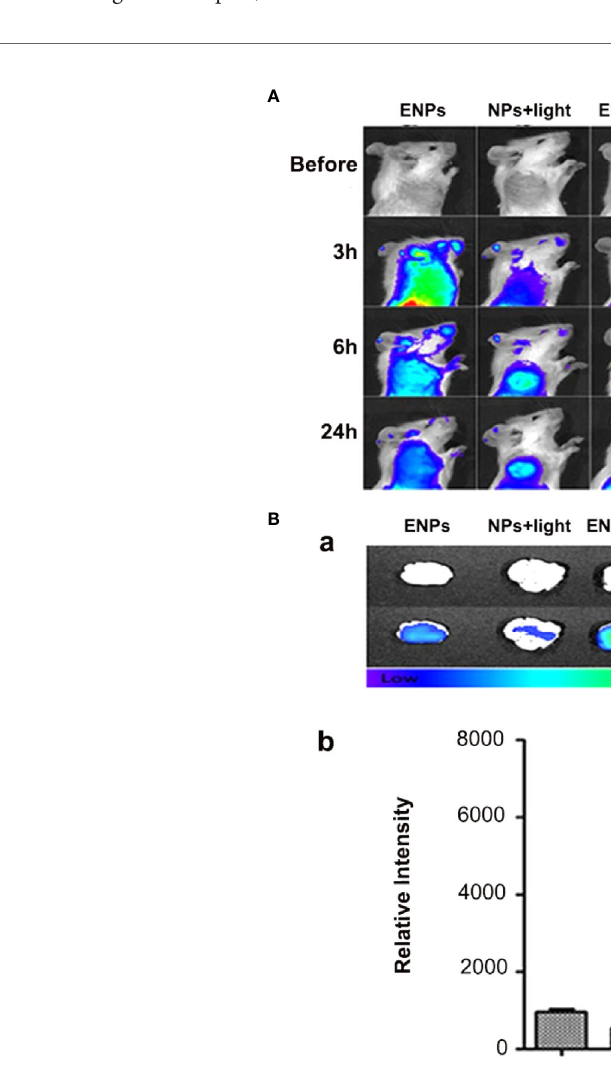
FIGURE 5 | Fluorescence imaging of nanoparticles post-PDT in tumor-bearing mice. (A) In vivo multispectral fl uorescent imaging of tumor-bearing mice at 3 h, 6 h, and 24 h post-PDT. (B) Tumors were incised at 24 h post-PDT for ex vivo multispectral fl uorescent imaging. a. white and fl uorescent images of tumor tissue; b. corresponding semi-quantitative fl uorescence intensities of tumors. Data are expressed as the mean ± SD (n = 3); **p <